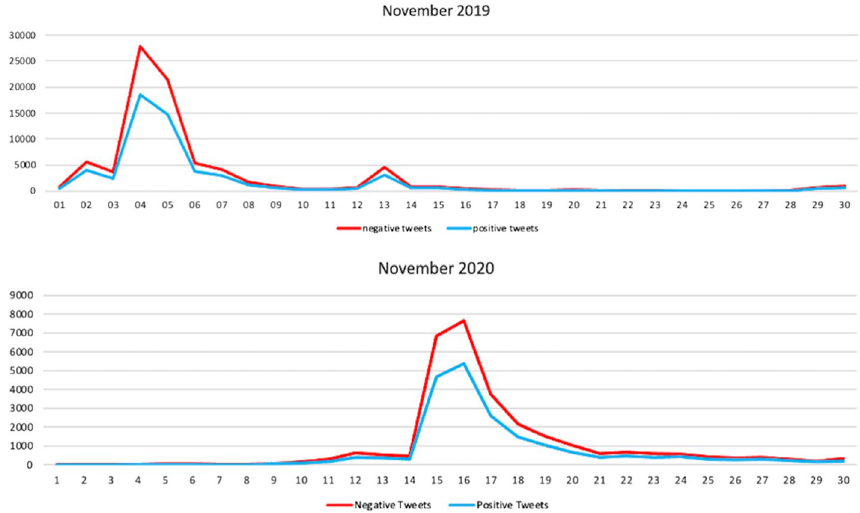
Fig. 11 Distribution of positive and negative tweets in November 2019 and November